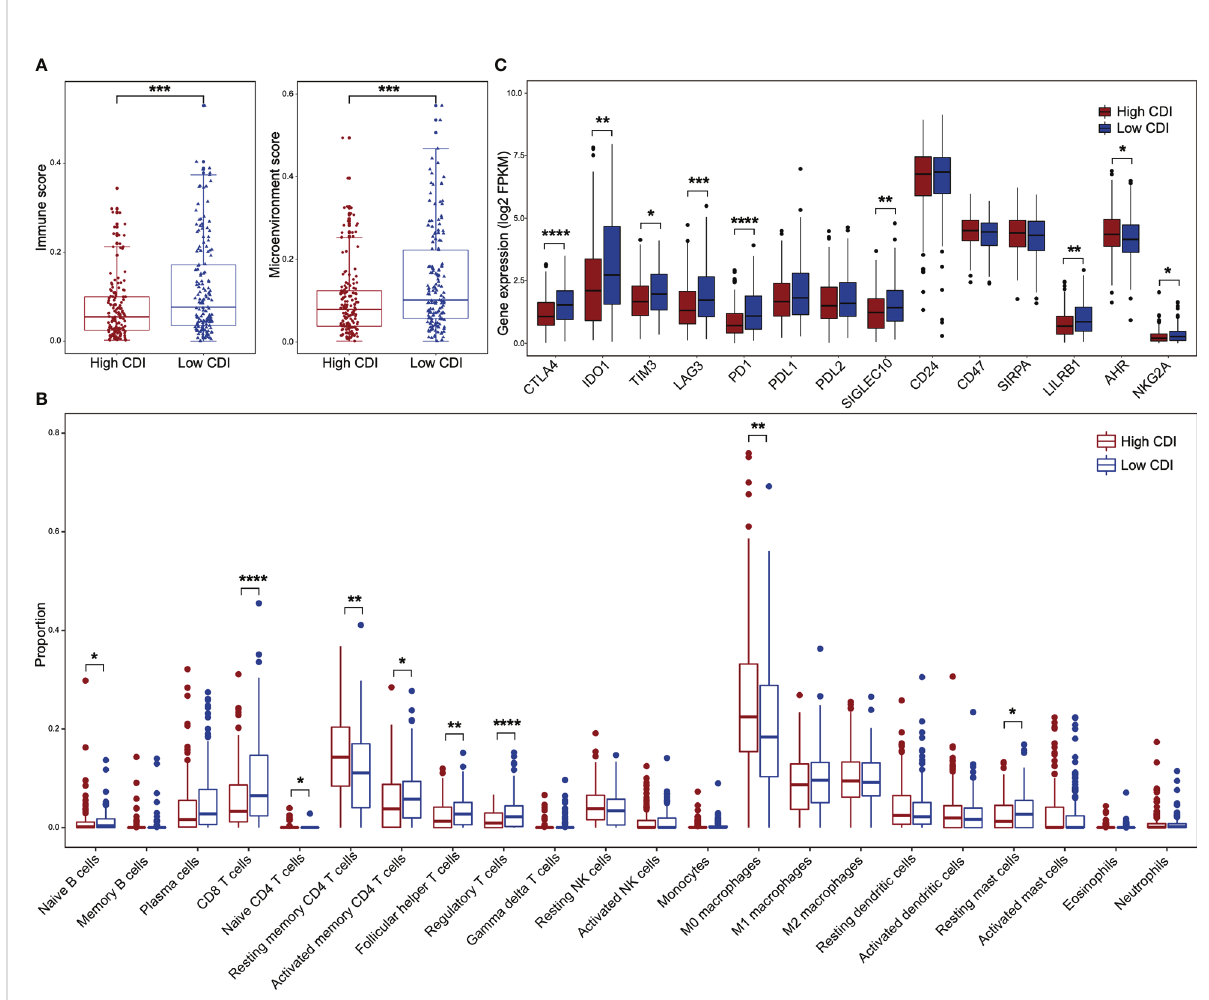
FIGURE 4 The immune landscape between high and low CDI HNSCC in HPV negative subgroup. (A) Boxplots illustrate the immune scores and the microenvironment scores of high and low CDI subgroups in HPV negative HNSCC assessed using XCELL. (B) Boxplots of relative proportions of in fi ltrating immune cells in high and low CDI subgroups in HPV negative HNSCC assessed using CIBERSORT. (C) Boxplots of the expressions of immune checkpoint genes in different CDI subgroups in HPV negative HNSCC. HNSCC: head and neck squamous cell carcinoma; CDI: cell death index; HPV: human papillomavirus. Statistical signi fi cance is assessed by Wilcoxon test. * P < 0.05, ** P < 0.01, *** P < 0.001, **** P <